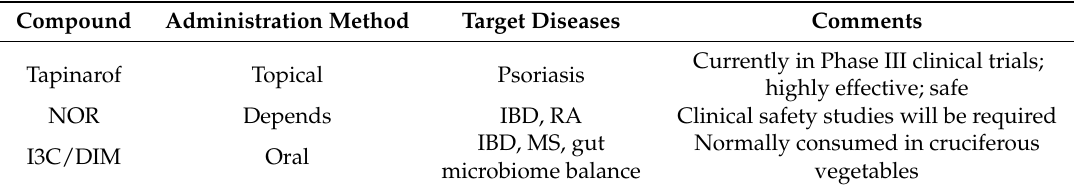
Table 3. AHR ligands with potential clinical